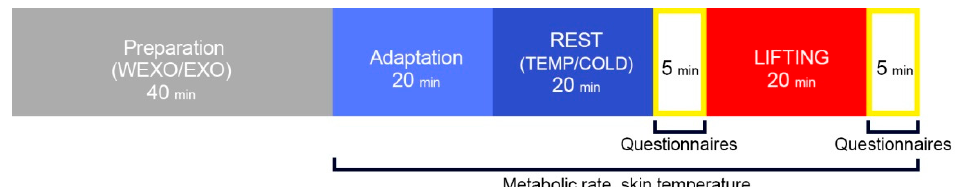
Figure 3. Experimental procedure.